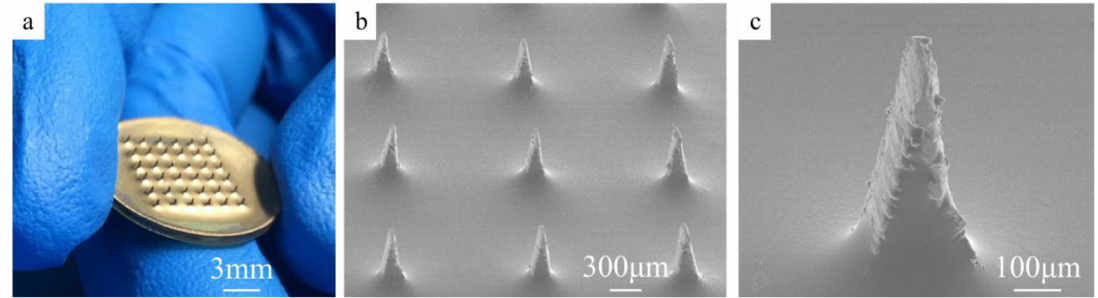
Figure 4. ( a ) Photograph of the CMAE; ( b ) SEM image of the CMAE; ( c ) SEM image of a single